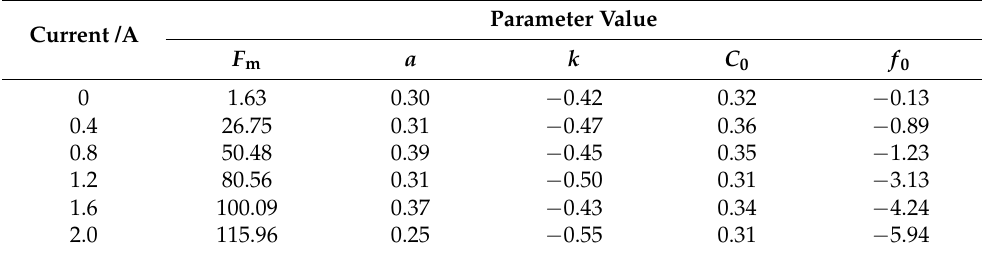
Table 4. Parameter identification results of adjustable sigmoid model.